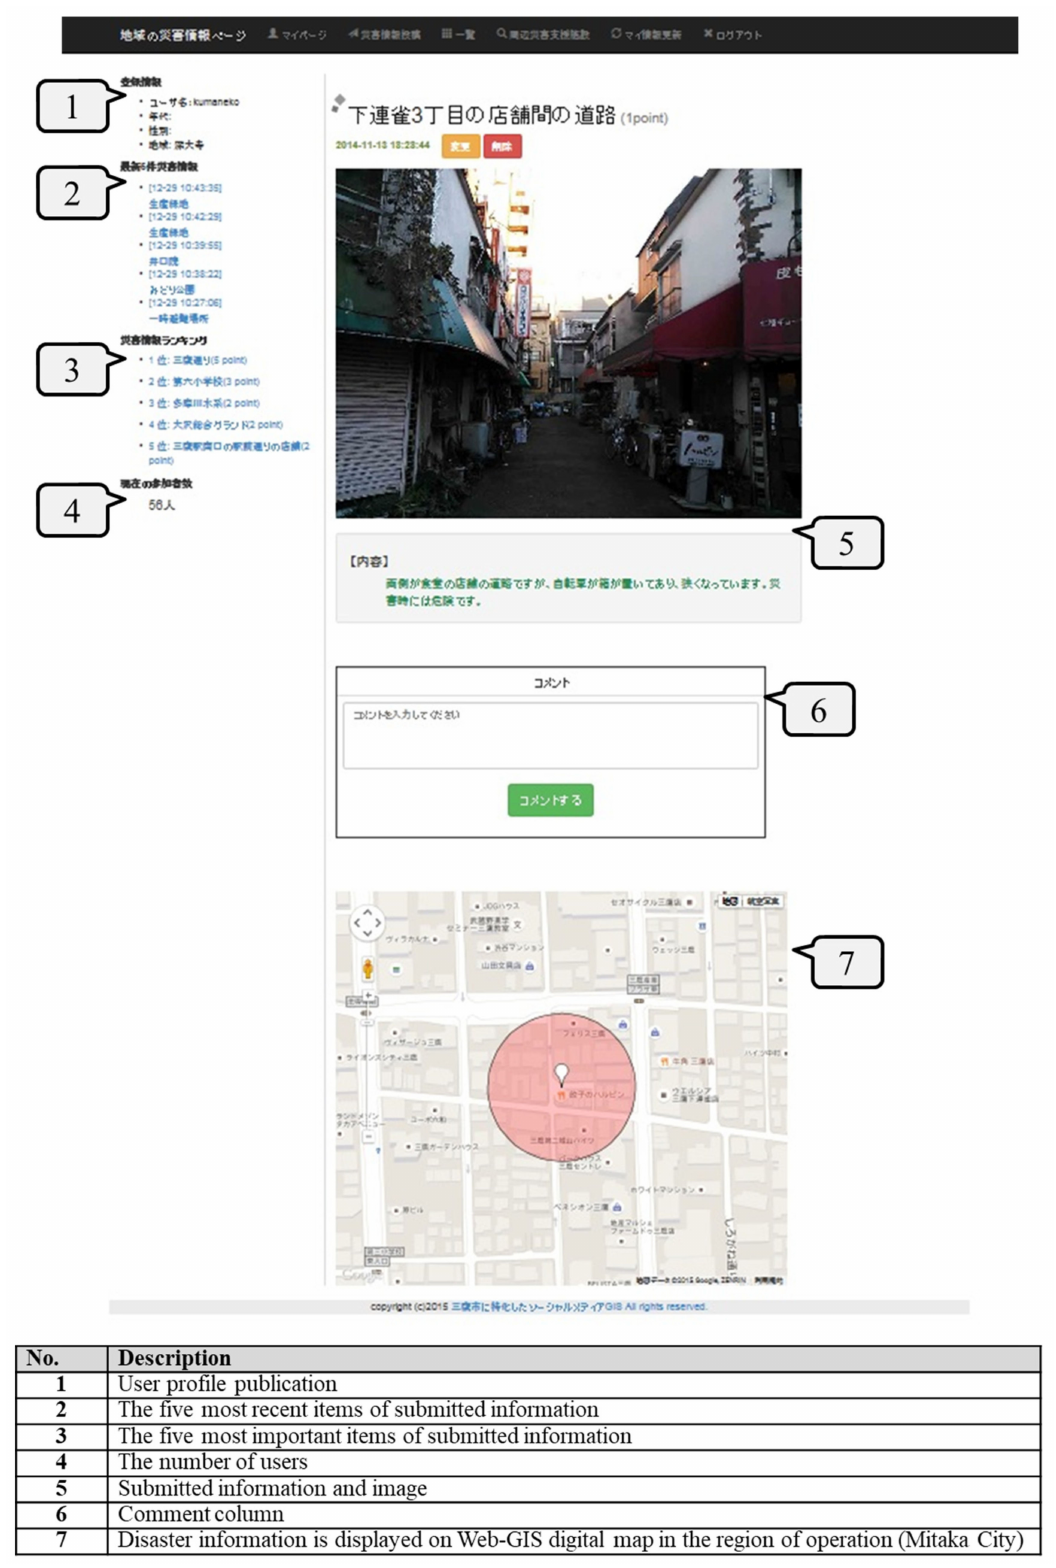
Figure 5. An example of submitted information on the social media GIS for disaster information